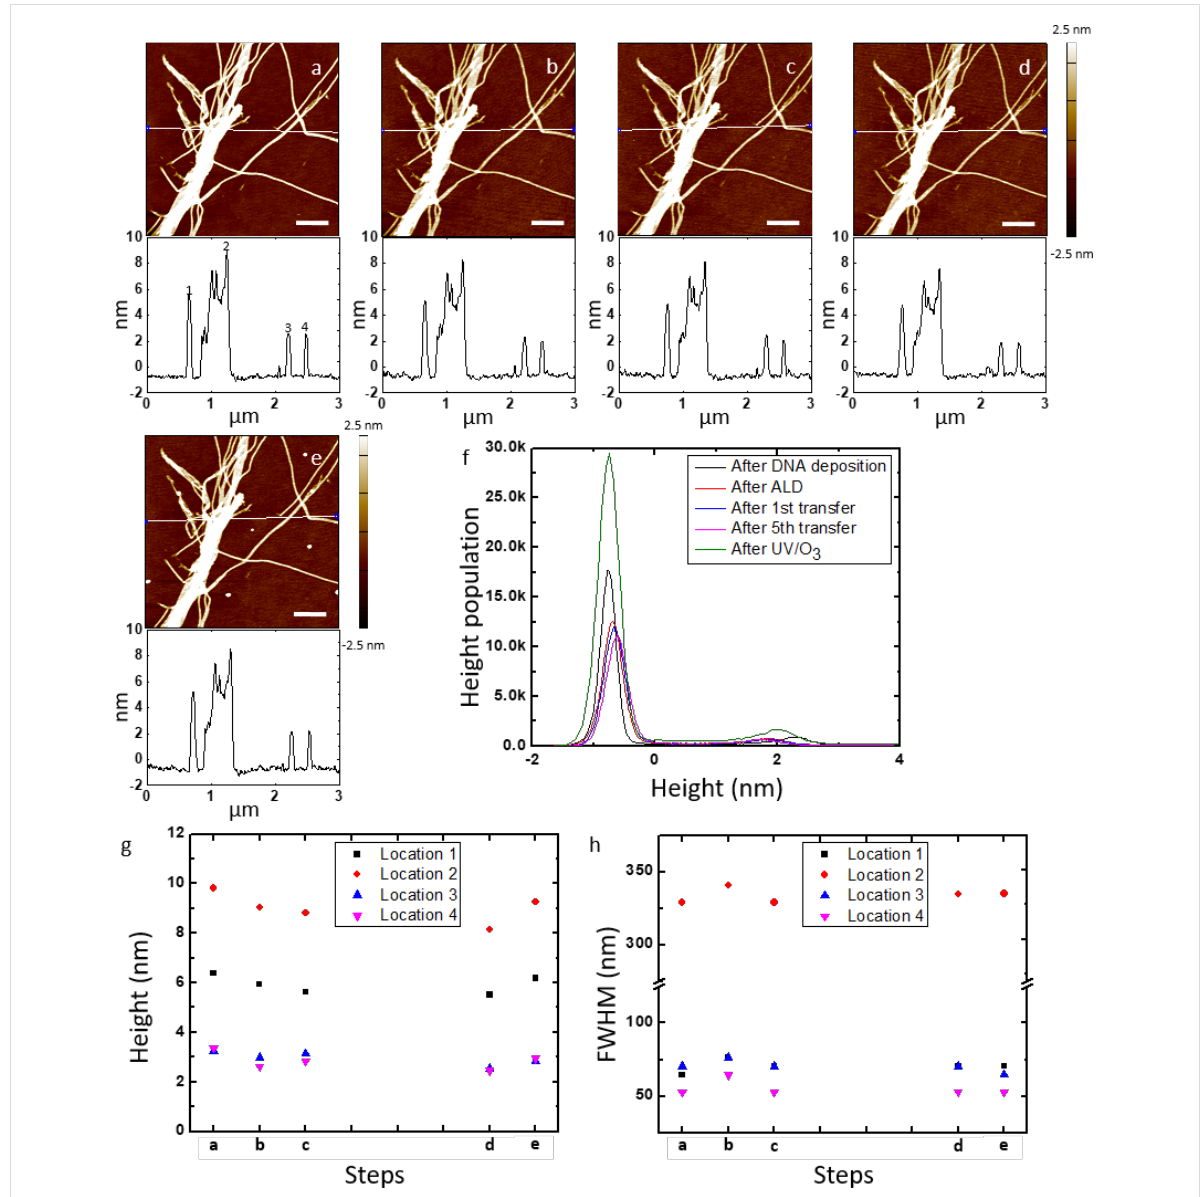
Figure 4: Stability of a DNA nanotube master template with a ca. 5 nm thick Al 2 O 3 film for multiple pattern transfers to PLLA stamps. AFM height images and corresponding cross-sectional analysis of DNA nanotubes in the same location after (a) deposited on a silicon wafer, (b) 50 cycles of ALD of Al 2 O 3 , (c) 1st and (d) 5th pattern transfer to PLLA stamps, and (e) UV/O 3 treatment for 1 h and washing with DI water. White lines on the AFM images indicate where the cross-sections were determined. (f) Histograms of the AFM height images from (a) to (e). (g) Height and (h) FWHM of the DNA nanotubes in four different locations of the AFM images from (a) to (e). Locations 1, 2, 3, and 4 correspond to 1, 2, 3, and 4 in the cross-section of the AFM image (a). Scale bars represent 500 nm. Note: The enlarged version of the histograms in (f) is available in Figure S6 (Supporting Informa- tion File